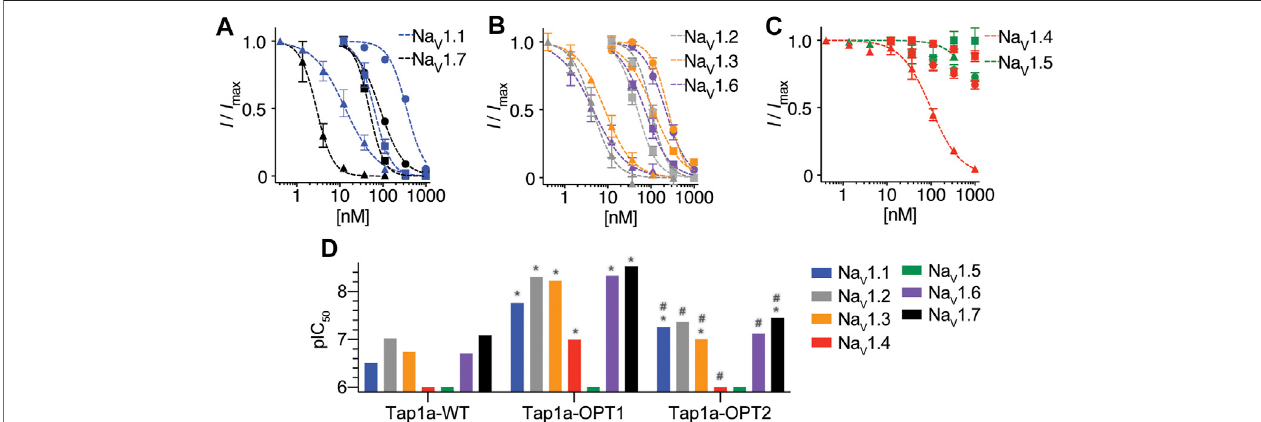
FIGURE 3 | Na V channel subtypes pharmacological pro fi le of Tap1a-WT, Tap1a-OPT1 and Tap1a-OPT2 determined using automated electrophysiology. (A – C) Representative concentration-responses for the inhibition of the hNa V 1.1 to hNa V 1.7 channels in the presence of increasing concentrations of Tap1a-WT (circles), Tap1a-OPT1 (triangles) and Tap1a-OPT2 (squares) measured by automated whole-cell patch clamp in QPatch 16X. Holding potential was – 80 mV and Na + currents were elicited by 20 ms voltage step to 0 mV from a – 120 mV conditioning pulse applied for 200 ms. The IC 50 values calculated are described in Table 2 (D) Comparison of the pIC 50 values for Tap1a-WT, Tap1a-OPT1 and Tap1a-OPT2 tested against hNa V 1.1 to hNa V 1.7 and calculated from the dose responsesproducedin (A – C) .*Statisticallysigni fi cantcomparedtoTap1a-WT; # Statisticallysigni fi cantcomparedtoTap1a-OPT1;Individual p valuesaredescribed in the text.